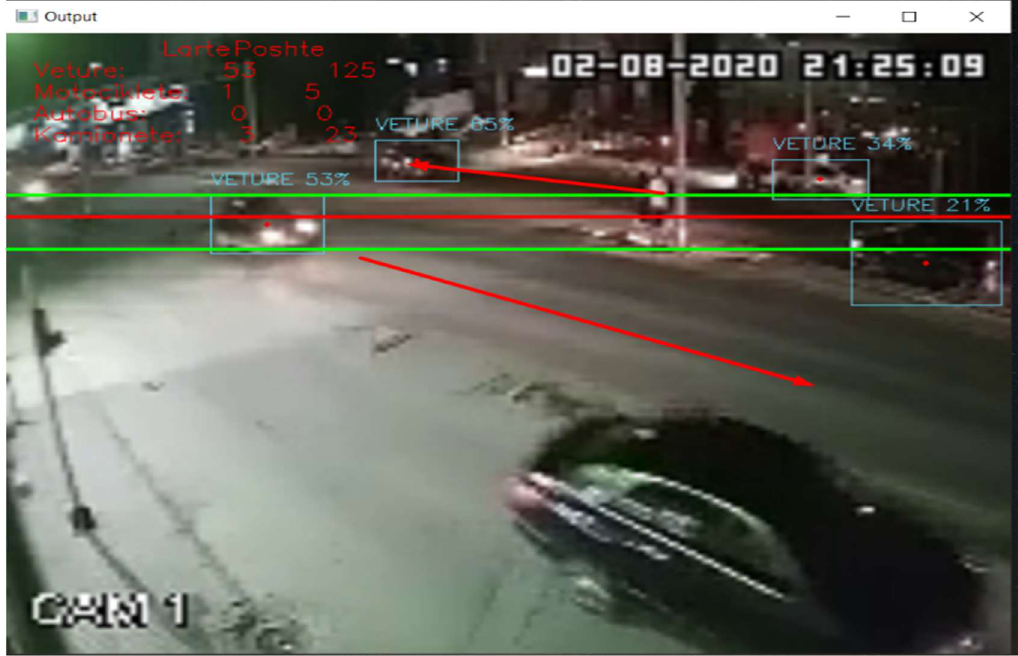
Figure 6. Traffic count from camera and data processing in program (time: 21:00–21:15). Table 2. Results obtained from camera count during the day. Table 1. Results obtained from camera count in the